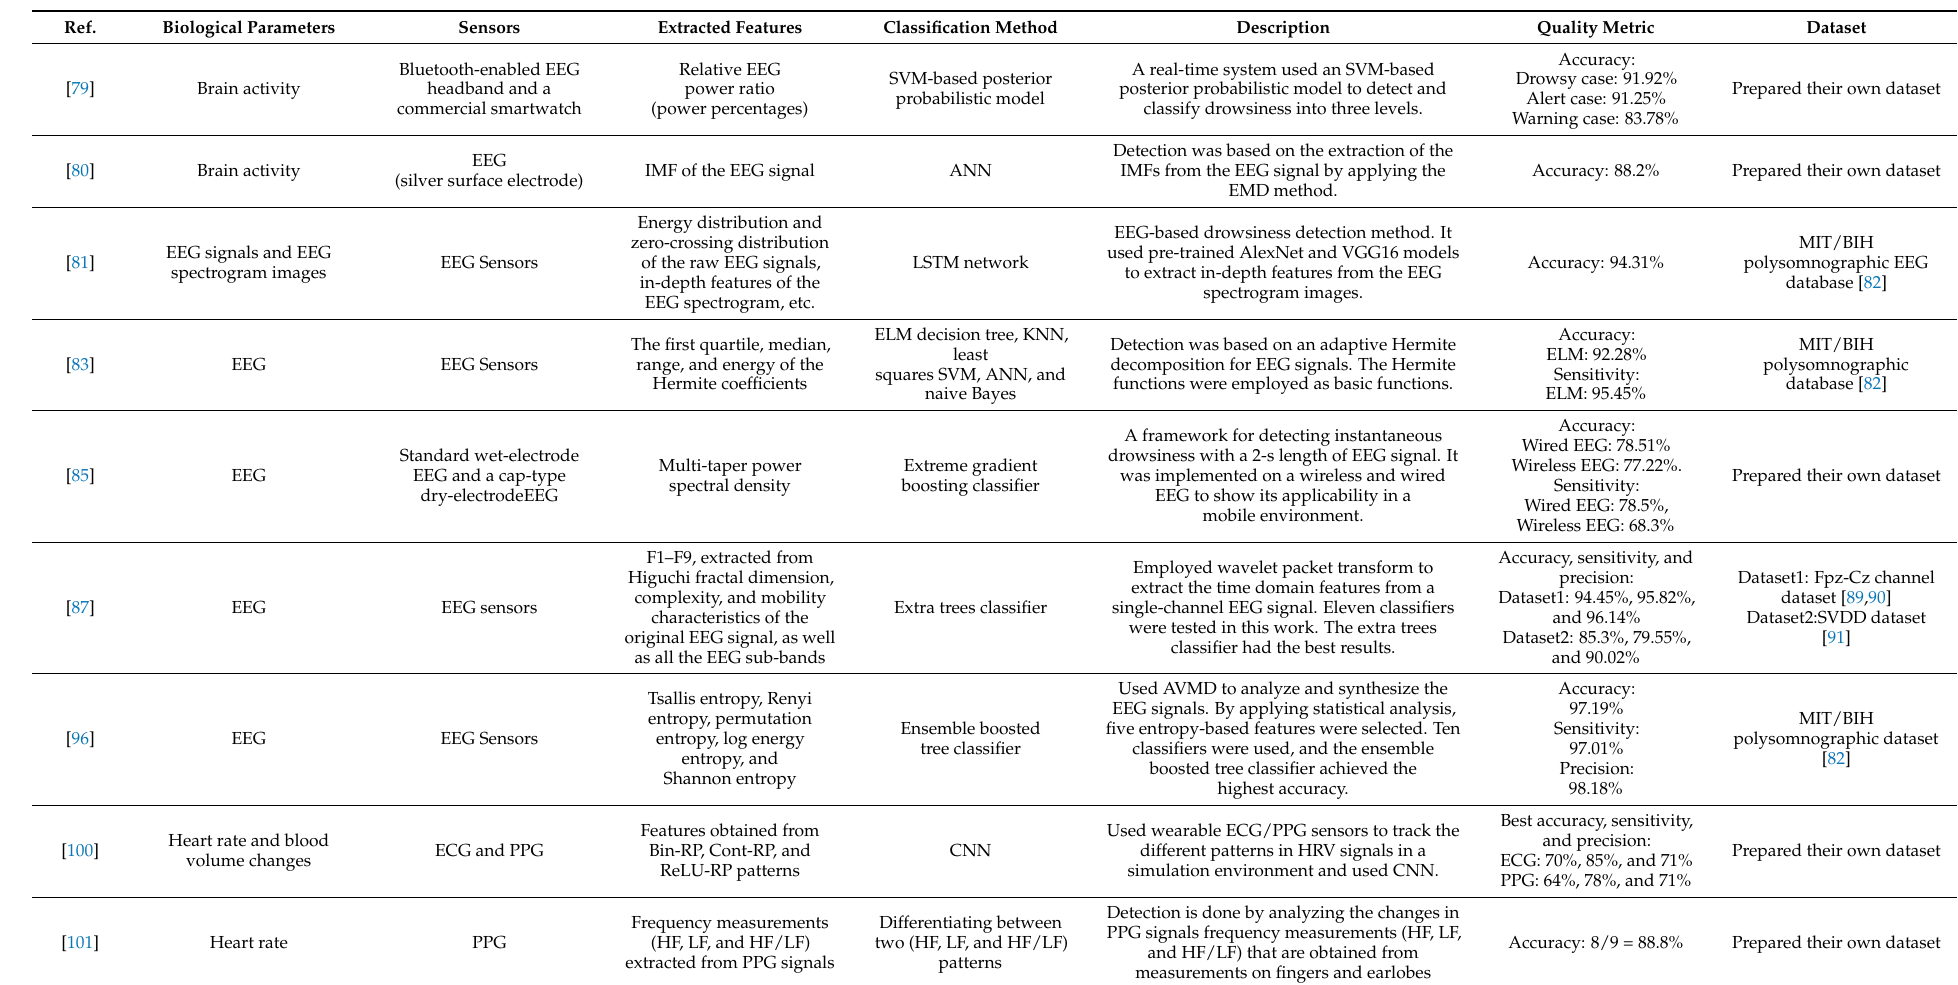
Table 6. Biological-based drowsiness detection